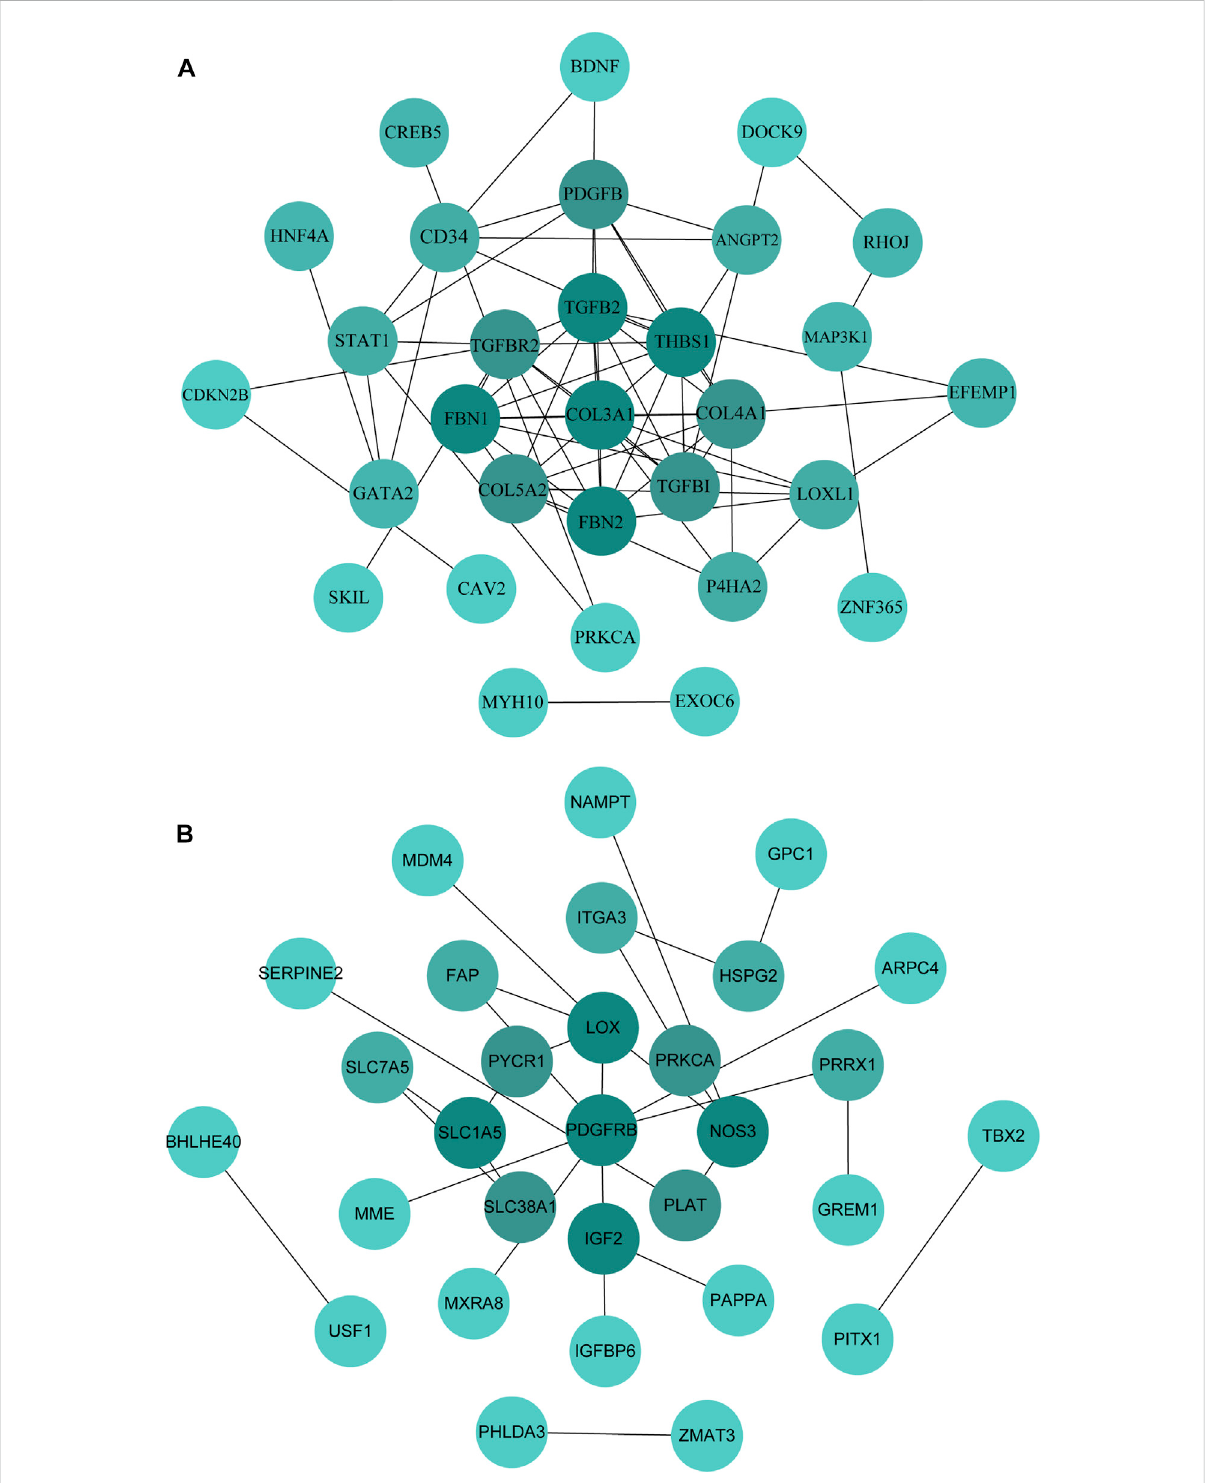
FIGURE 7 Identi fi cation of the hub genes in the PPI network. (A) : PPI network of the top 30 hub genes for upregulated genes. (B) : PPI network of the top 30 hub genes for downregulated